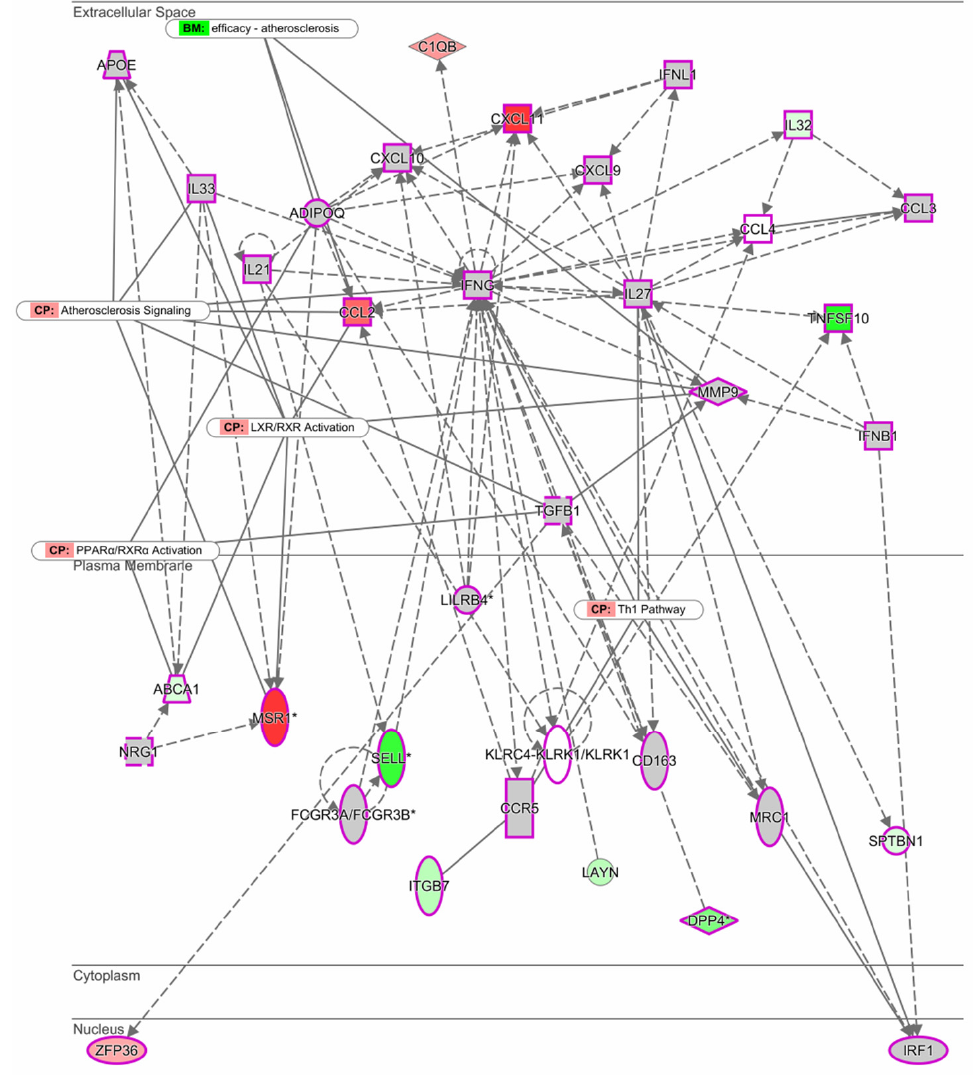
Figure 2. Expression network between men and women. The intensity of the node color-(red) indicated the degree of up-regulation. Genes in uncolored notes were not identified as differentially expressed in our experiment and were integrated into the computationally generated networks based on the evidence stored in the Ingenuity Pathway Analysis (IPA software, QIAGEN). The node shapes denote enzymes ( ), G-protein coupled receptor ( ), transmembrane receptor ( 0 ), cytokines ( ), growth factor ( ⬚ ), transporter ( ), translation factor ( ), and other ( ). (*) indicate multiple identifiers in the dataset file map to a single gene/chemical in the Global Molecular Network. Graphs were plotted using IPA software by QIAGEN.